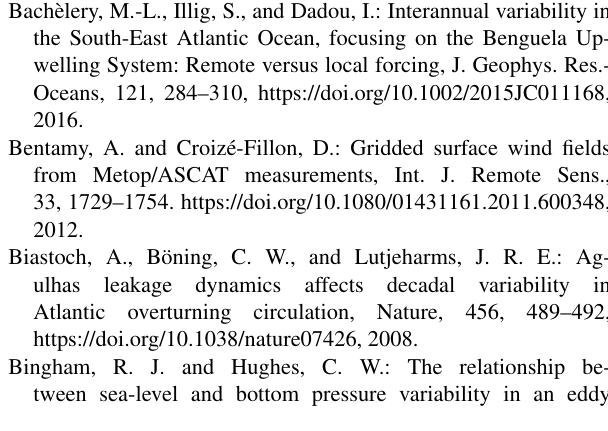
figuration and access to data available at